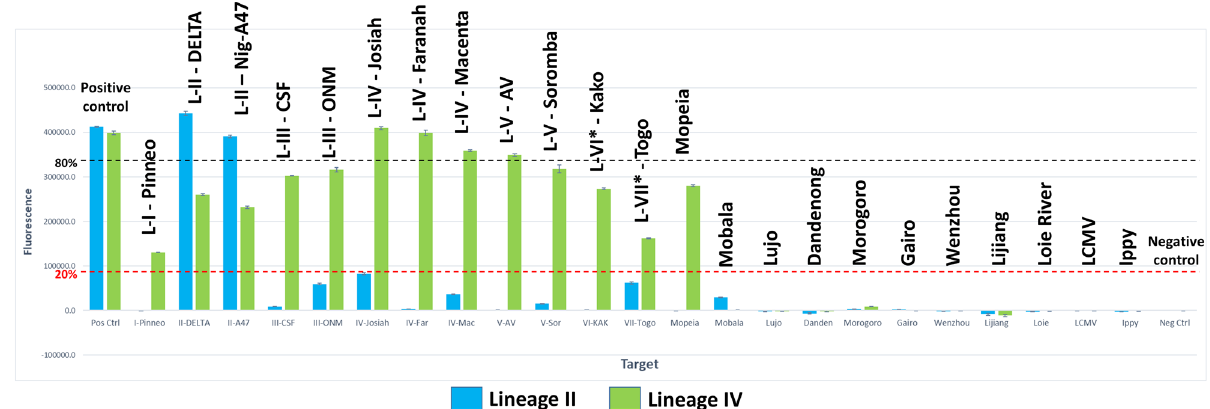
Figure 2. crRNA #5—detection of LASV lineages and near-neighbors. Results of testing of crRNAs #5_LII and #5_LIV with a panel of 12 LASV targets representing all currently known lineages (I–VII) and 11 near-neighbor old world arenavirus (OWA) targets. The height of the bars reflect the cumulative background subtracted fluorescence obtained for each of the tested crRNAs against the specific target.